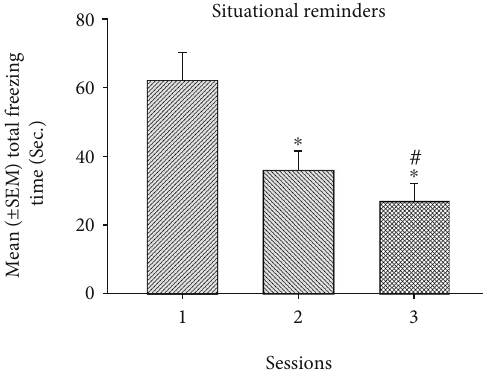
Figure 4: The mean ( ± SEM) total freezing time (Sec.) in the situational reminders for sessions 1-3. ∗ p < 0 : 05 indicates signi fi cant di ff erences compared to session 1. # p < 0 : 05 indicates signi fi cant di ff erences compared to session 2.